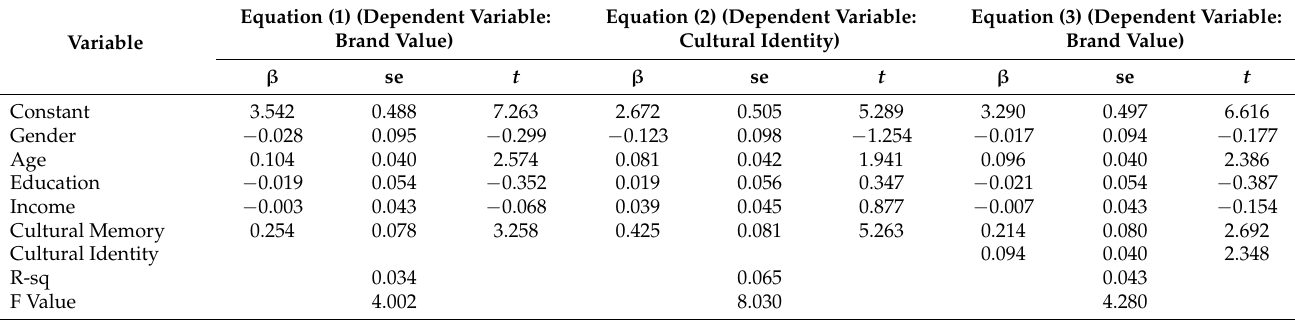
Table 7. Hypothesis test results.